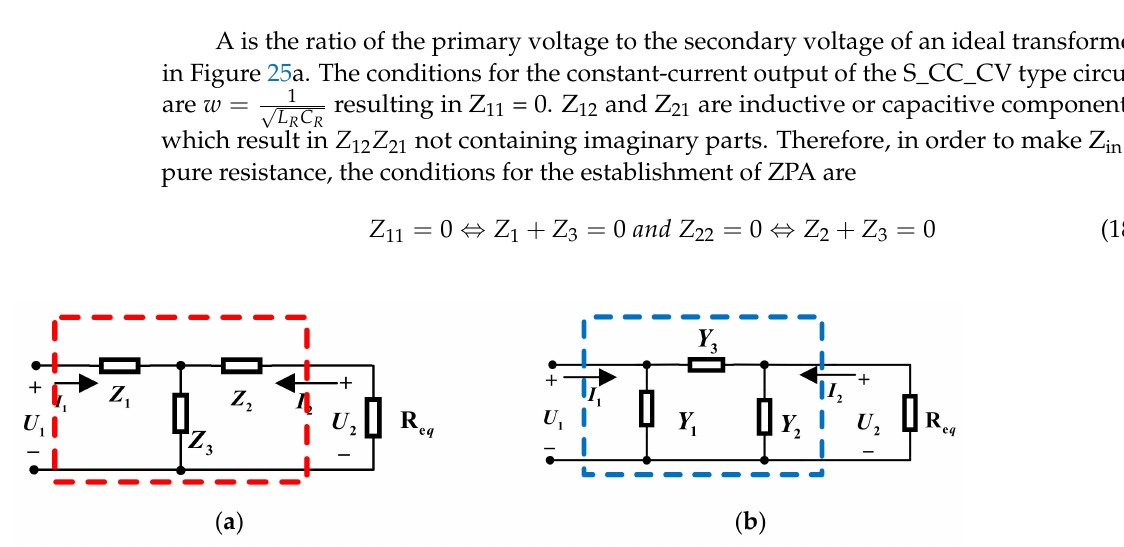
Figure 25. ( a ) The zero-phase angle (ZPA) condition of S_CC_CC compensation topology and ( b ) The ZPA condition of CV_CV_L compensation topology.